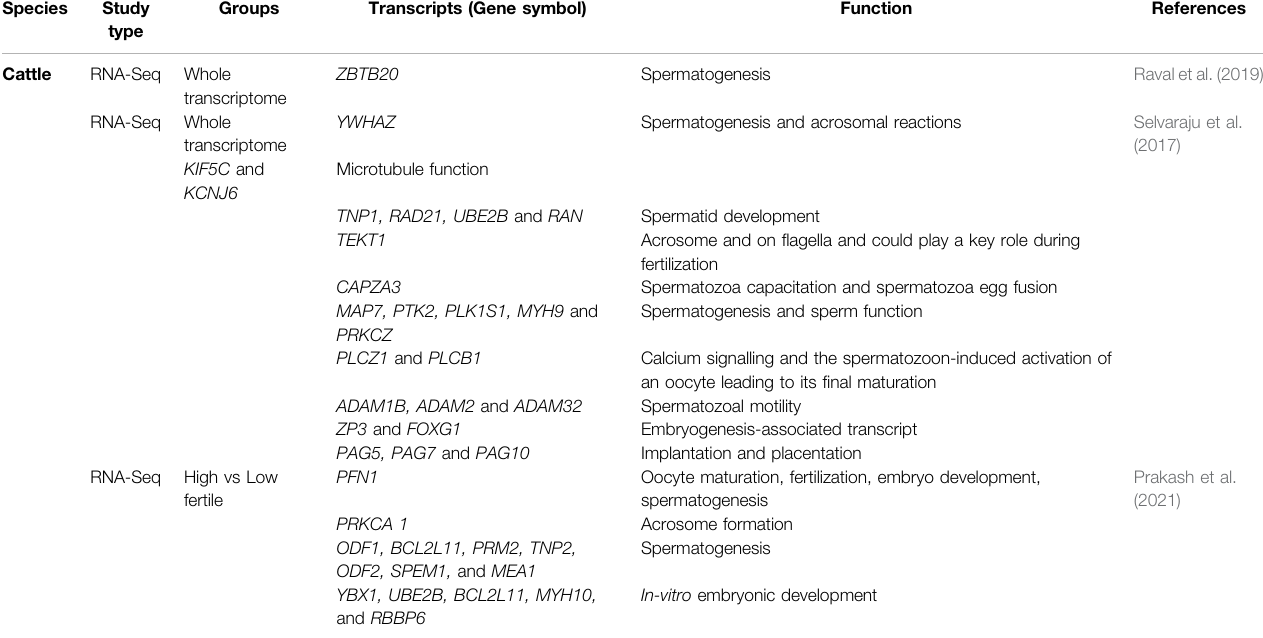
TABLE 1 | Important protein coding transcripts reported in cattle spermatozoa by transcriptome analysis.